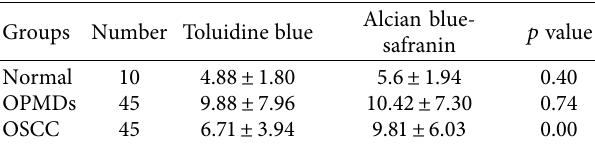
Table 3: Comparison of mast cells between toluidine blue stain and Alcian blue-safranin